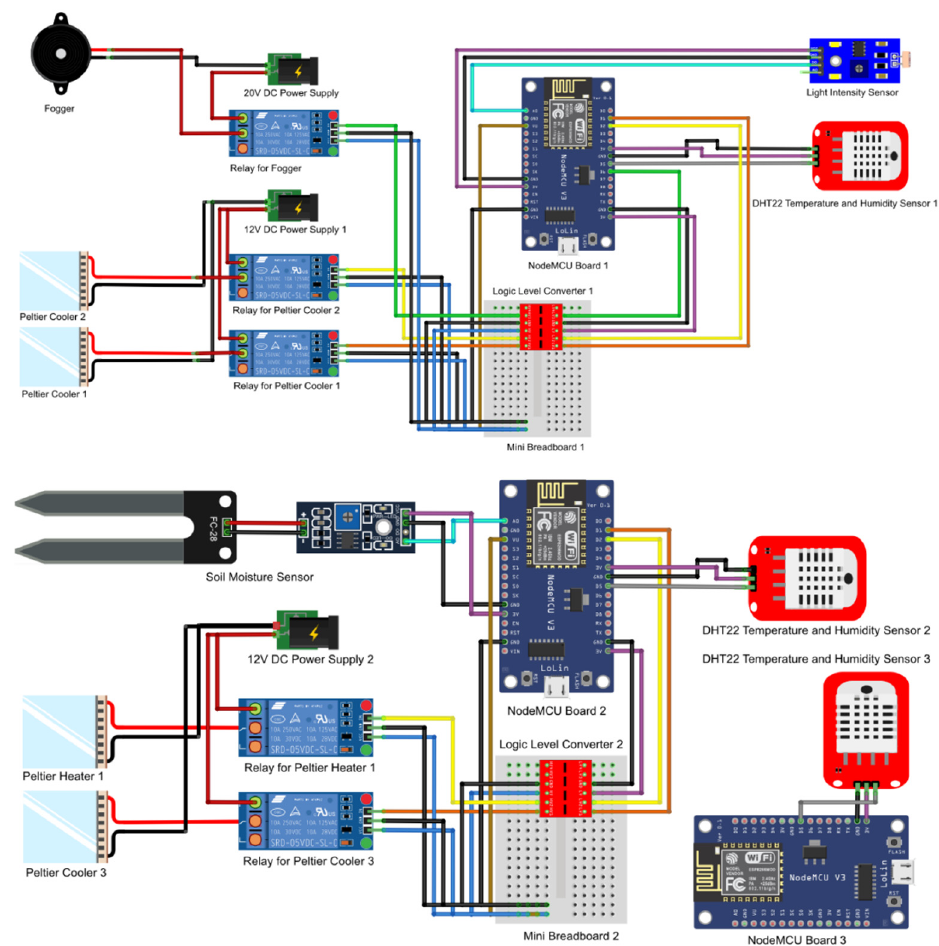
Figure 5. The actual schematic diagram for the NodeMCU board 1, 2 and 3.